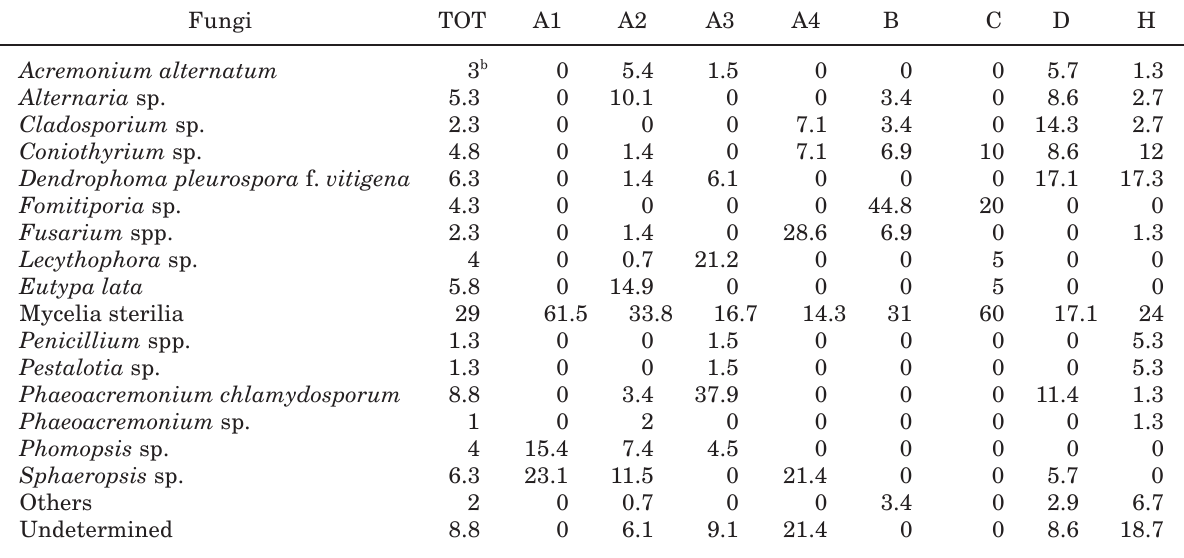
Table 1. Percentage of colonies of the most frequent fungi (>1% over the total amount, TOT) isolated from the different categories of tissues (A1 to H) a . Fungi Acremonium alternatum Alternaria sp. Coniothyrium sp.